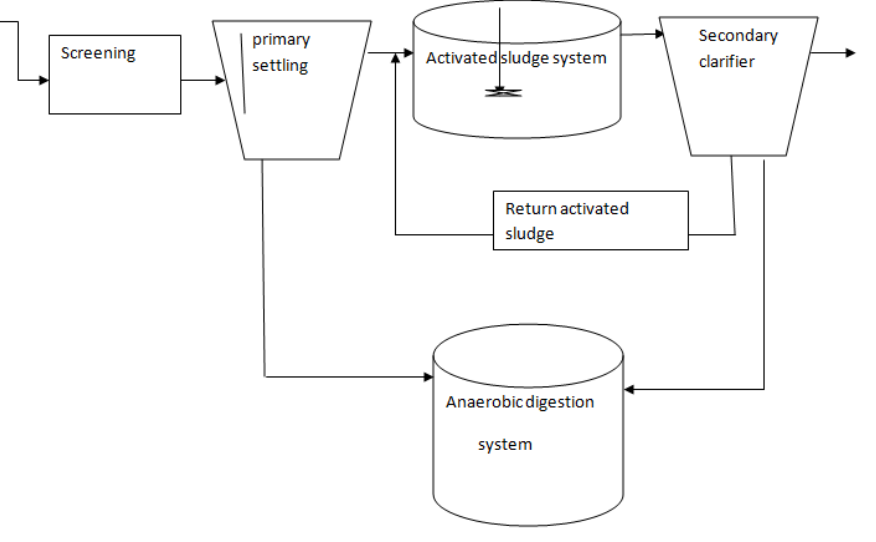
Figure 1. Major processes in the conventional wastewater treatment system.